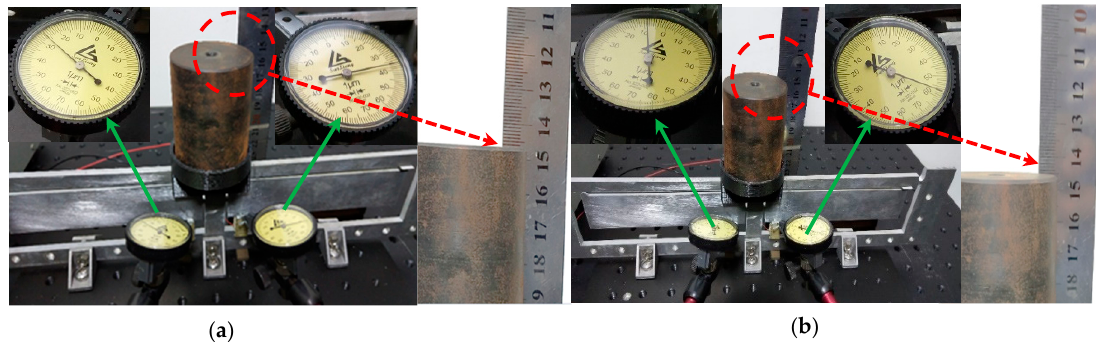
Figure 10. The initial and final experimental deformation of the focusing mechanism based on a two-stage flexural hinge lever-type mechanism. ( a ) Experimental deformation of the focusing mechanism with no input force and ( b ) experimental deformation of the focusing mechanism with input force.